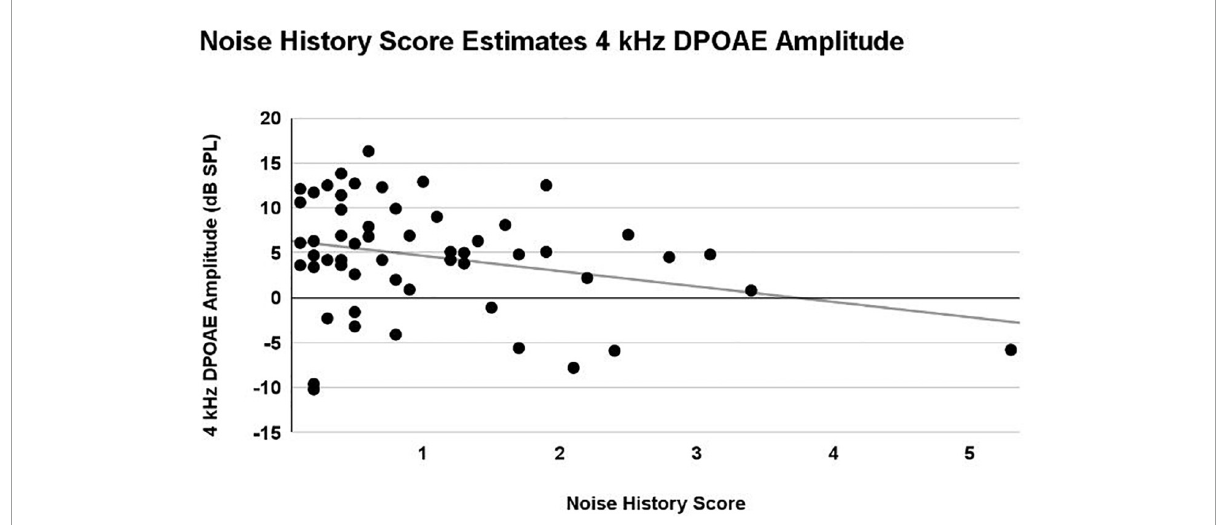
FIGURE7 A linear mixed model with repeated measures (right and left ear) was used to analyze the effects of ear, sex, firearm group, and Noise History Score on measures of auditory function. Only an effect of Noise History Score was statistically significant ( p = 0.03) in the 4 kHz DPOAE amplitude (dB SPL) measurement. Right and left ear averaged data are shown here, demonstrating a weak correlation, with 4 kHz DPOAE amplitude decreasing as Noise History Score increased ( R = 0.28).